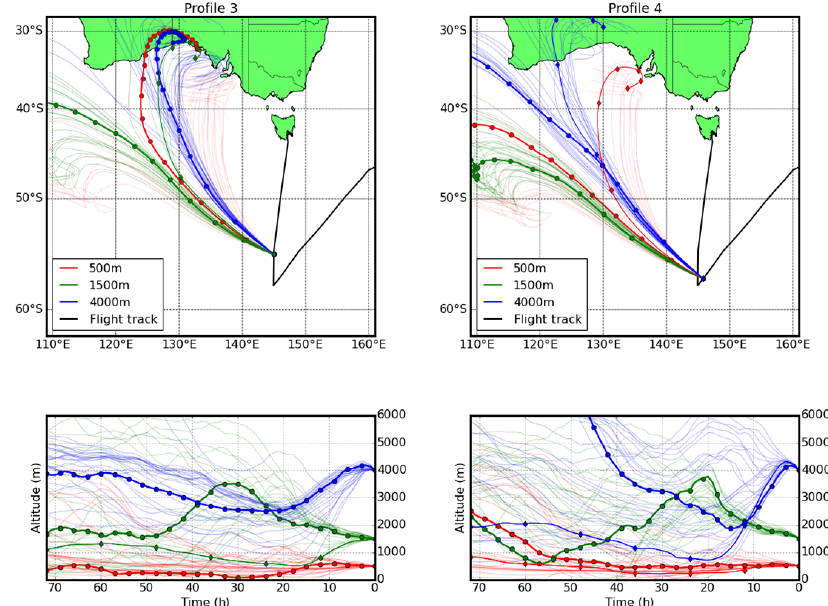
Figure 8. As for Fig. 7, but for profiles 3 and 4. In this figure some additional ensemble members, which represent substantially different airmass histories from the “deterministic” trajectories, have been highlighted with 12 hourly diamond